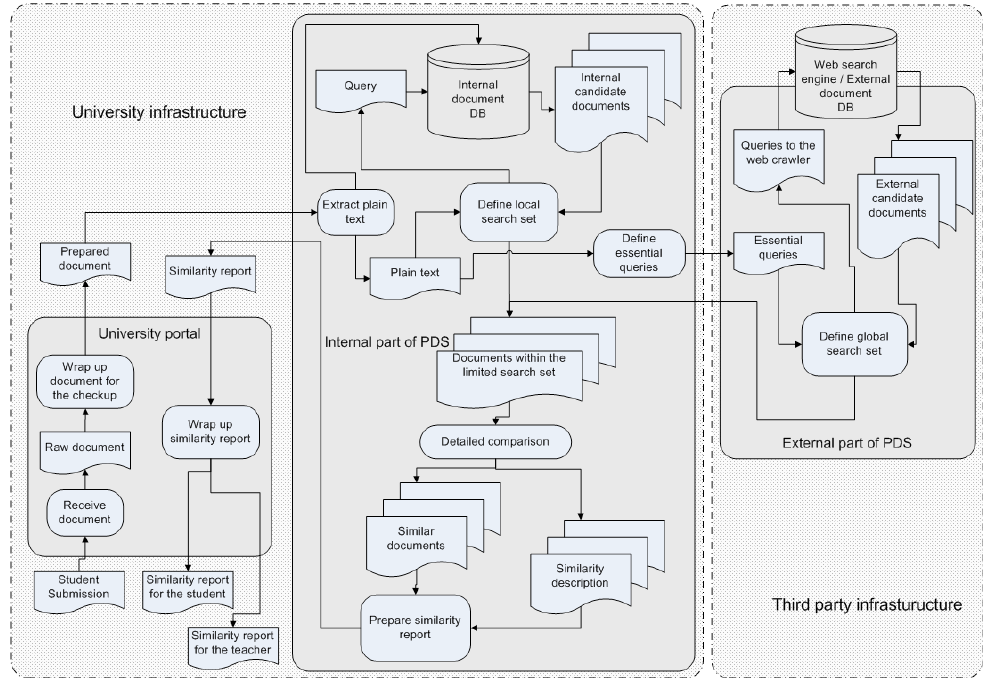
Figure 3 . Outline of the proposed architecture for